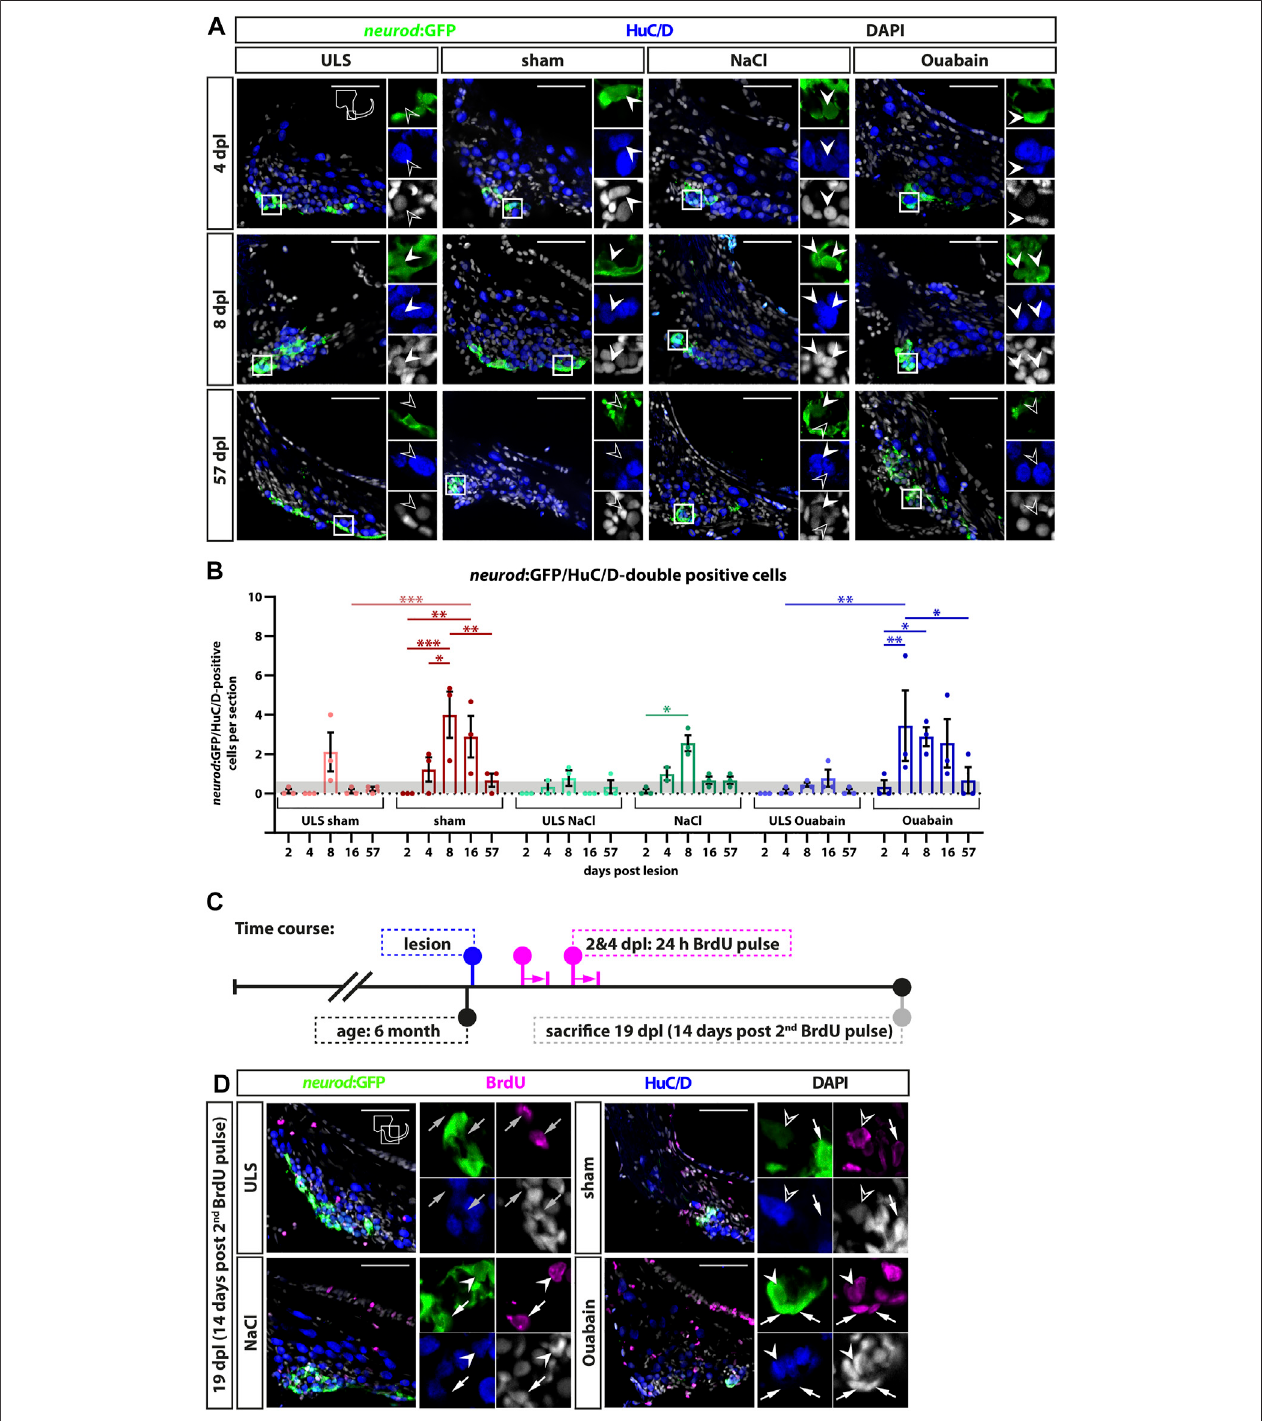
FIGURE6 | Generationof newsensoryneurons from the neurod :GFP-positiveprogenitor pool upon lesion. (A) Short-term lineage tracing using the persistence of GFP in the SAG of neurod :GFP transgenic animals. Immunohistochemistry against the neuronal marker HuC/D and GFP label newborn neurons in sham-treated, and NaCl- and ouabain-injected animals as well as the unlesioned side (ULS) of either sham-treated, or NaCl- or ouabain-injected animals at 4, 8, and 57 days post lesion (dpl). Shown are representative overviews of the neurogenic niche of the SAG as well as close-ups to visualize co-staining. At 4 dpl, several neurod :GFP/HuC/D double-positive cells can be found in the lesioned side independent of the type of lesion, whereas neurogenesis is almost not existing in the corresponding unlesioned side (upper row). At 8 dpl, neurogenesis is abundant in the lesioned sides and increased as well in the respective unlesioned sides in sham-treated, and NaCl- and